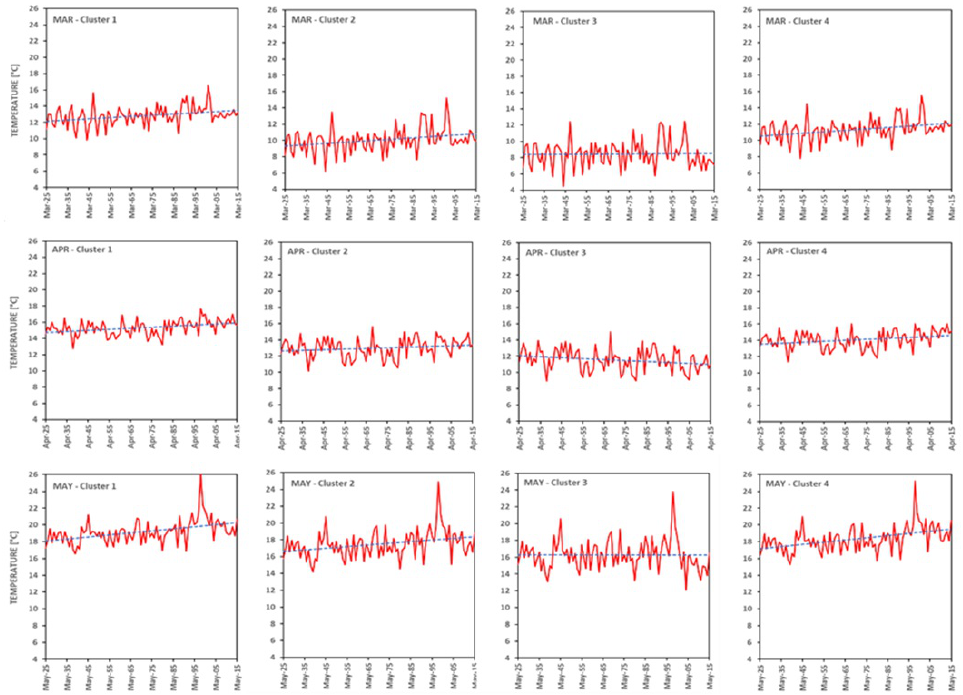
Figure 5. Trend of average monthly temperatures from 1925 to 2015 for each Cluster (quarter Mar– Apr-May).